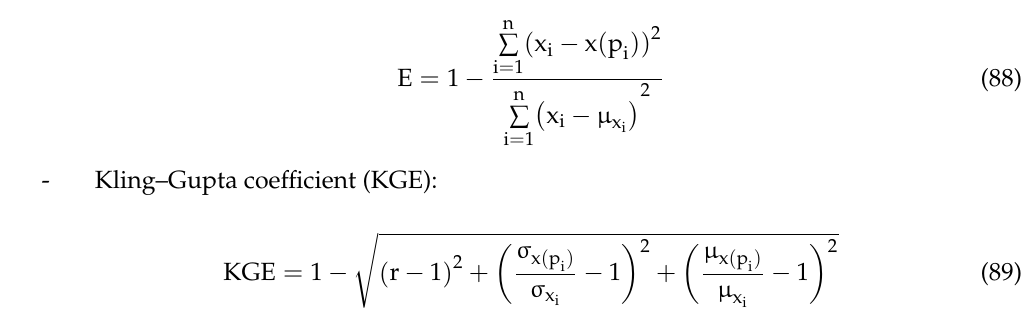
Table 8. Estimated parameter values.